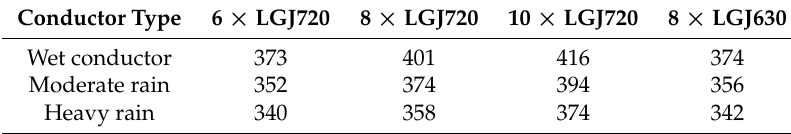
Table 4. Experimental values: the corona onset voltage under different weather conditions (kV).